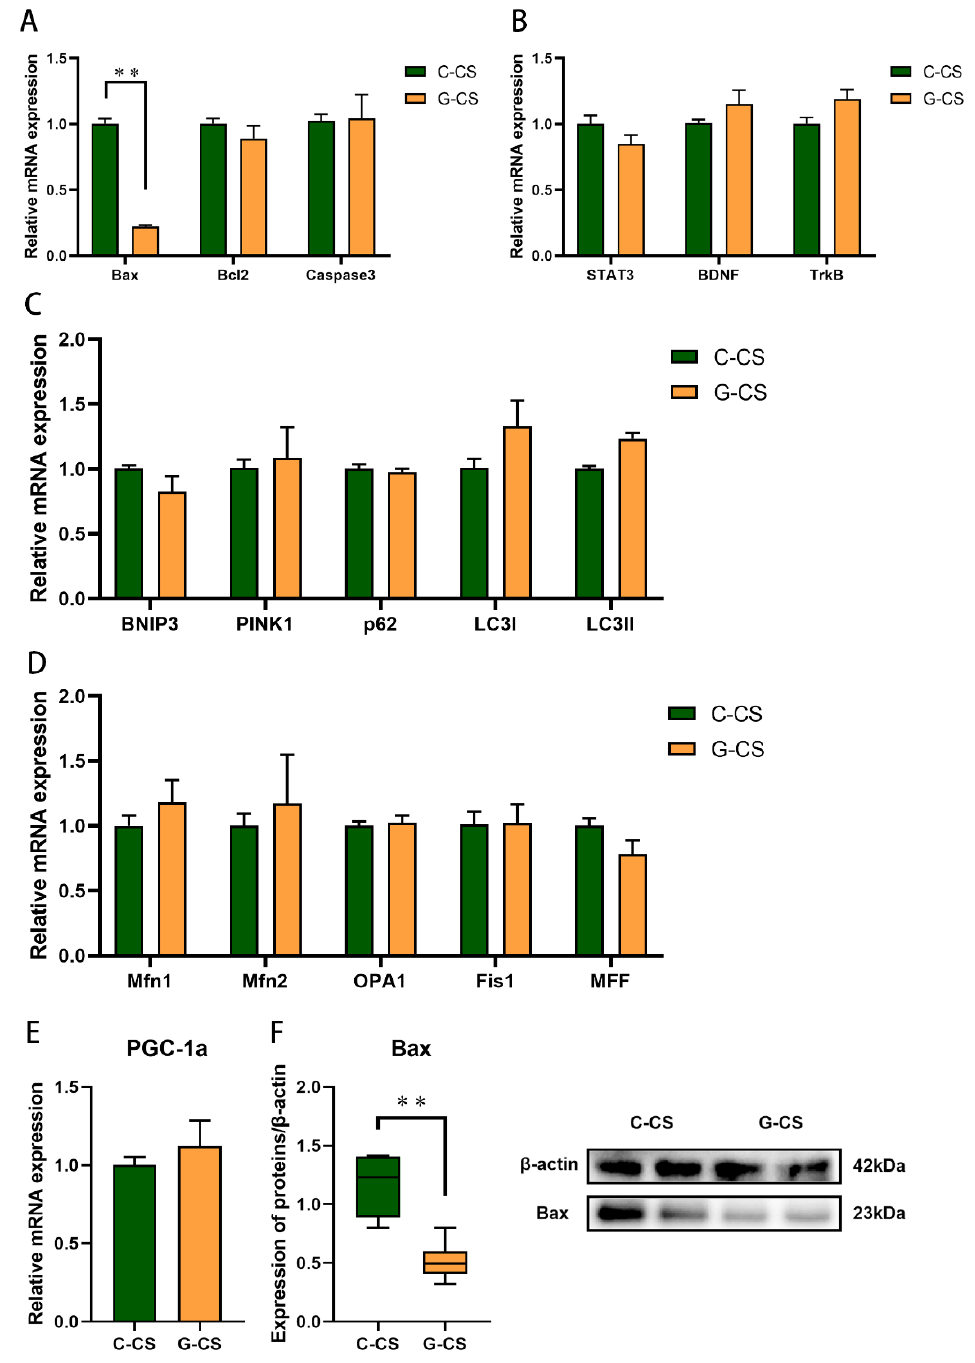
Figure 7. Glucose supplementation improved the apoptotic pathway in lungs during chronic cold exposure. ( A ) Apoptotic pathway related mRNA expression. ( B ) STAT3-BDNF-Trkb pathway mRNA expression. ( C ) Expression of genes related to mitochondrial autophagy. ( D ) Expression of genes related to mitochondrial dynamic balance. ( E ) PGC-1 α mRNA expression. ( F ) Bax protein expression. Data are expressed as the mean ± SEM, n = 6, ** p <